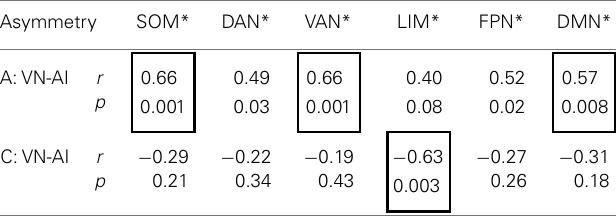
Table 6 | Partial correlations (adjusted for age) betweenVN-AI and